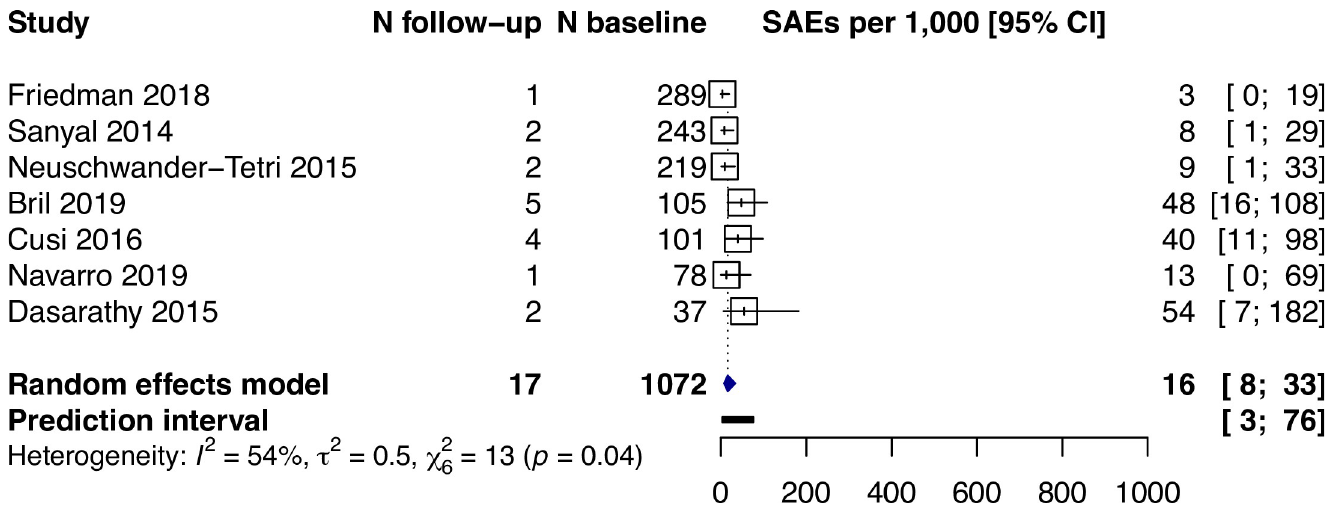
Fig 4. Biopsy-related serious adverse events reported for N per 1,000 participants (95% CI).